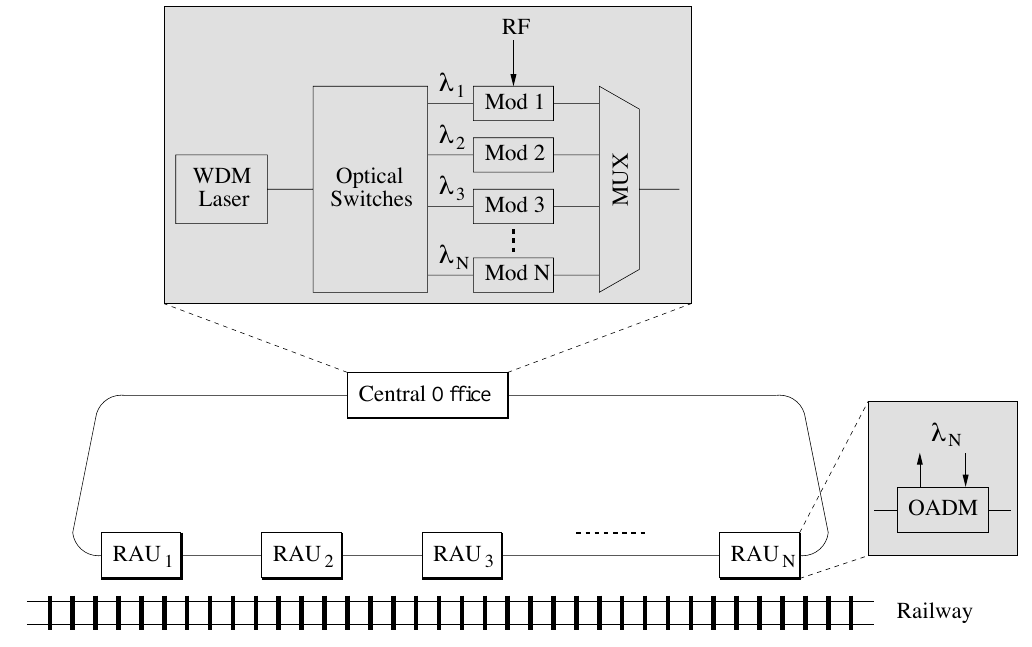
Figure 4. Moving cell-based RoF network architecture for train passengers